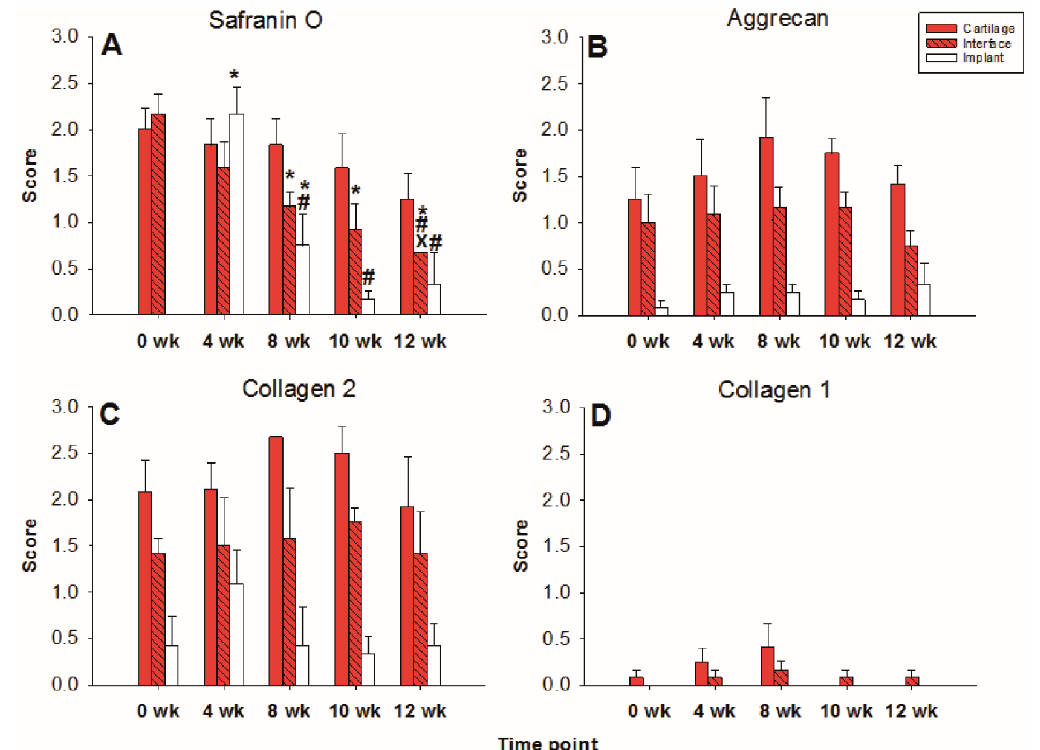
Figure 3. Semiquantitation of the (immuno)staining for Safranin O ( A ), aggrecan ( B ), collagen 2 ( C ), and collagen 1 ( D ) in “host” cartilage, cartilage–implant interface, and PGA implant (cell-free) after different periods of in vitro culture. Score: 0 = no staining, 1 = weak staining, 2 = moderate staining, 3 = strong staining; means +/ − standard error (SEM) of the mean; symbols show p ≤ 0.05 versus: * 0 weeks; # 4 weeks; or X 8 weeks.